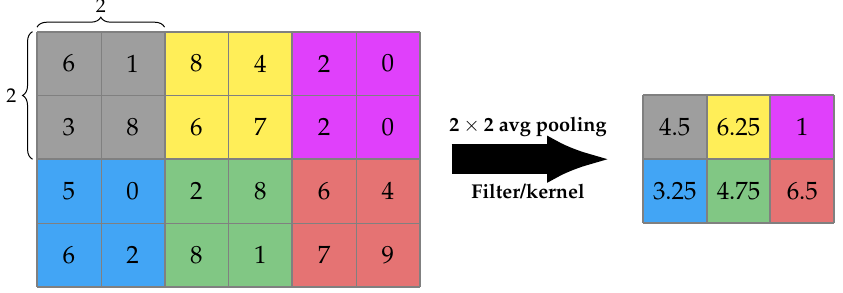
Figure 3. An example of Average pooling’s functionality